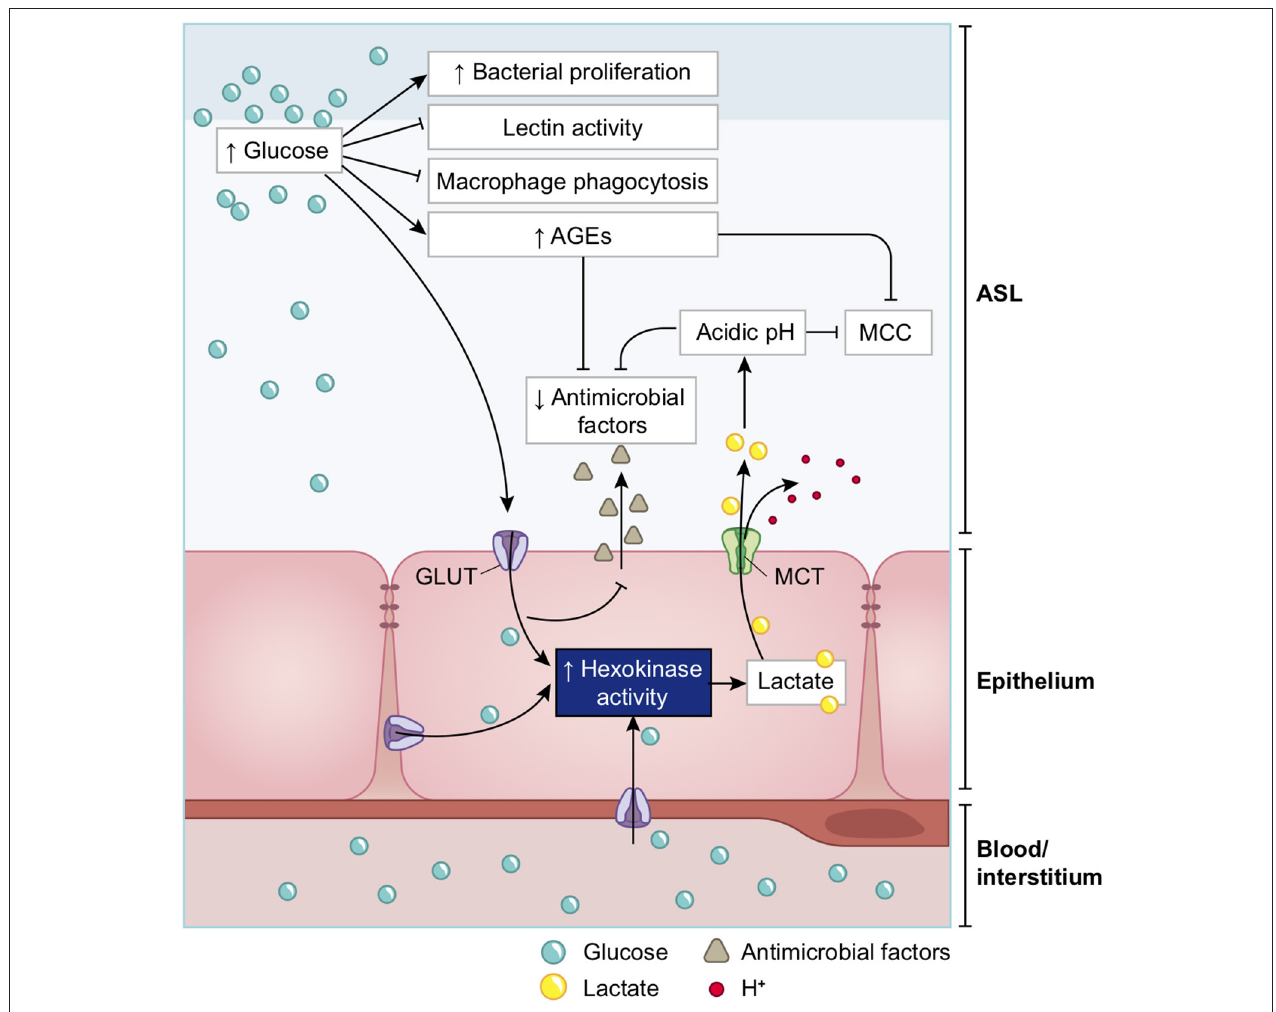
FIGURE 15 | Schematic of the impacts of increase in ASL glucose on ASL functions. High glucose in the ASL has multiple consequences on the immune defense system of the ASL. Innate defense capacities, such as the activity of lectins and macrophages are directly impaired by elevated glucose. High glucose also leads to the production of AGEs that reduces the activity of other antimicrobial factors (such as defensin or lactoferrin), and leads to a reduction of the MCC capacity. Additionally, more glucose from the ASL is uptaken by the epithelial cells, leading to an increased production of intracellular lactate. Lactate is then partially released in the ASL trough MCT transporters, consequently leading to an acidification of the ASL due to the co-transport of H + . Acidic pH aggravates the impairments of antimicrobial and MCC activities. Finally, elevated glucose is a direct supply for bacterial proliferation in the ASL. AGEs, Advanced glycation end products; MCC, mucociliary clearance; MCT, monocarboxylate transporter.